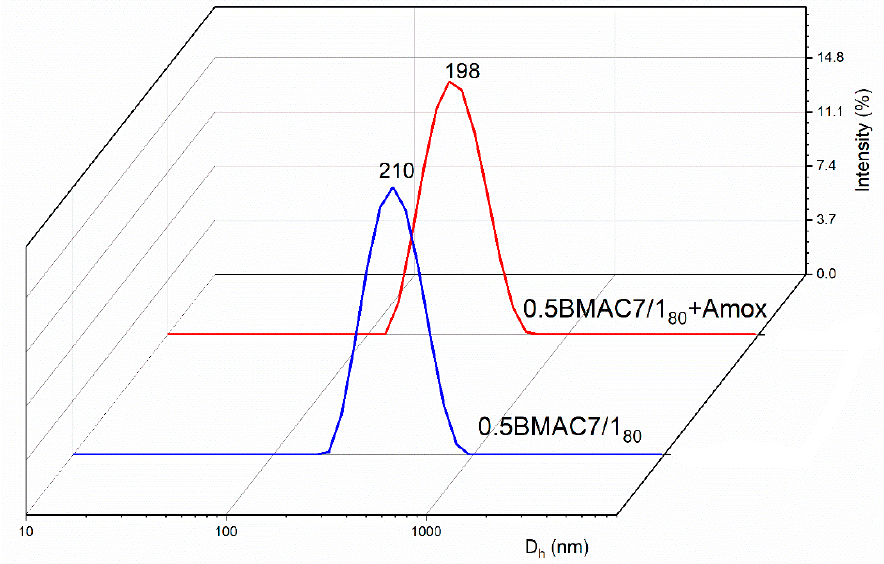
Figure 6. Size distribution of unloaded/amoxicillin (Amox)-loaded 0.5BMAC7/1 80 nanogels.